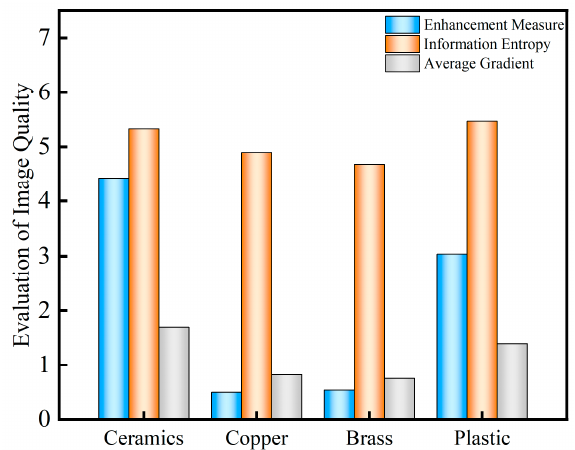
Figure 10. Image DOP quality evaluation of different targets.